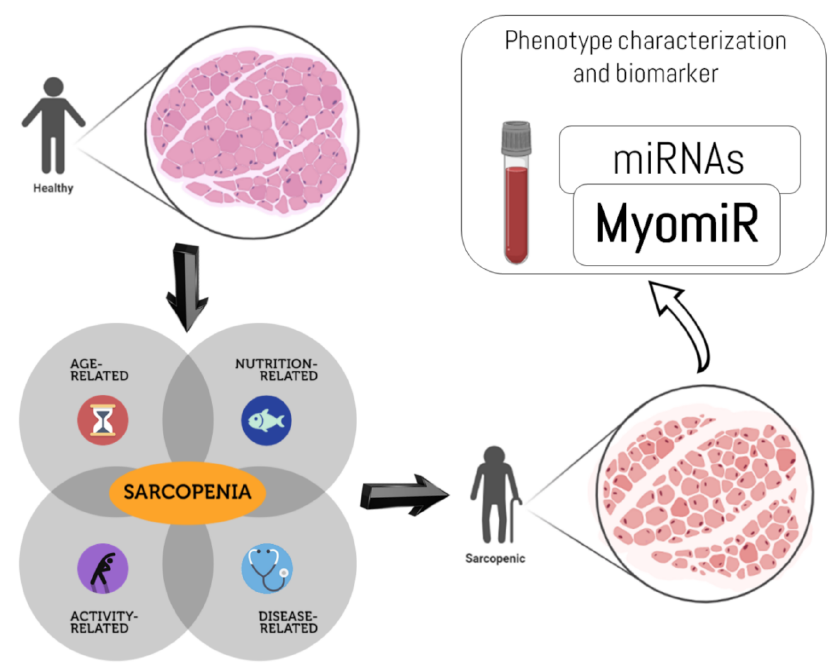
Figure 1. Sarcopenia and the muscle microRNAs (myomiRs). Representation of the main domains of the sarcopenia etiology, the changes in muscle cross-sectional area of lean and intramuscular adipose tissue, and the potential role of the miRNAs secreted by musculoskeletal tissue (myomiRs). Other several neuro-morphophysiological changes (i.e., dysfunction of peripheral nerves, alterations of the neuromuscular junction, modifications of sarcomeric proteins, reduction in the number of the satellite cells, and loss of mitochondrial content and function, among others) are not shown.